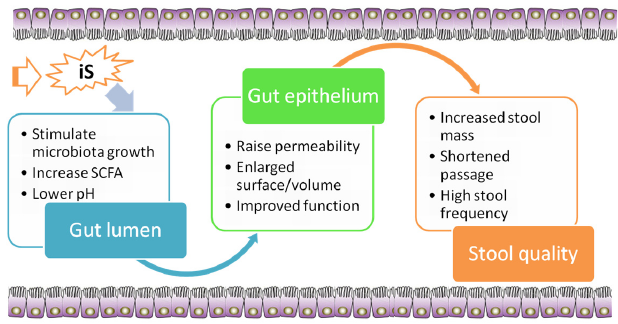
Figure 1. Summary of prebiotic effects of dietary indigestible sugars (iS) in the large